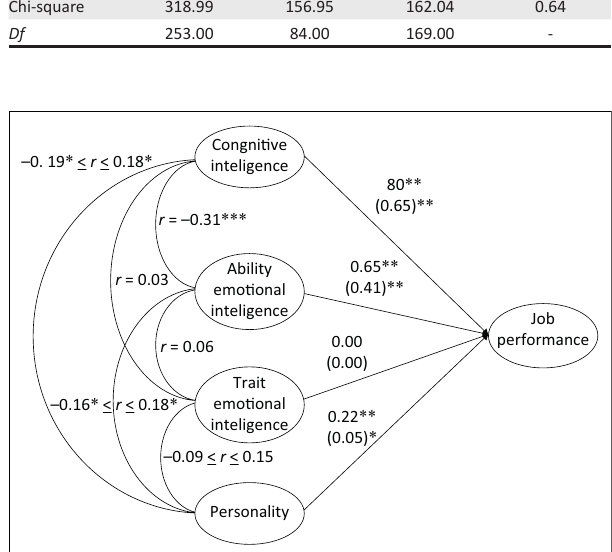
FIG URE 1: The final structural equation modelling prediction model: Model 1. Note: *** p ≤ 0.001; ** p ≤ 0.01; * p < 0.05.